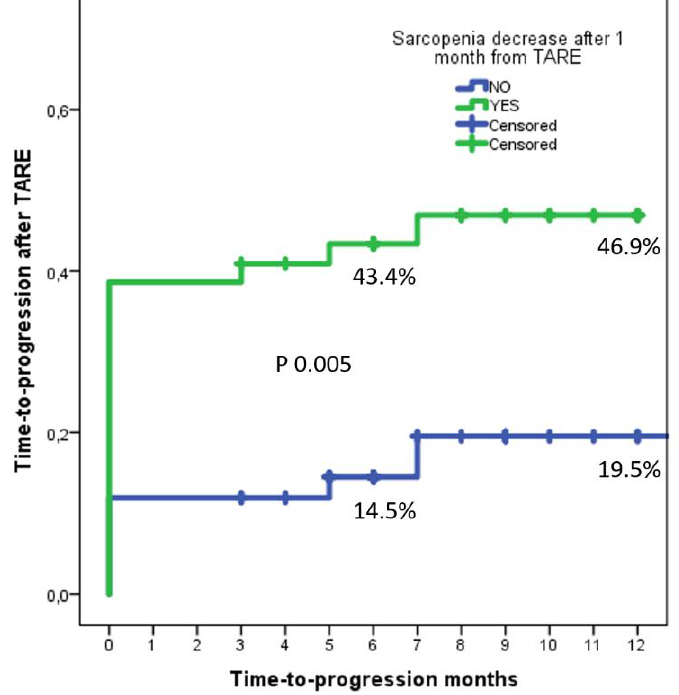
Figure 5. Delta-PMI at one month was statistically significant as an independent risk factor for PD,